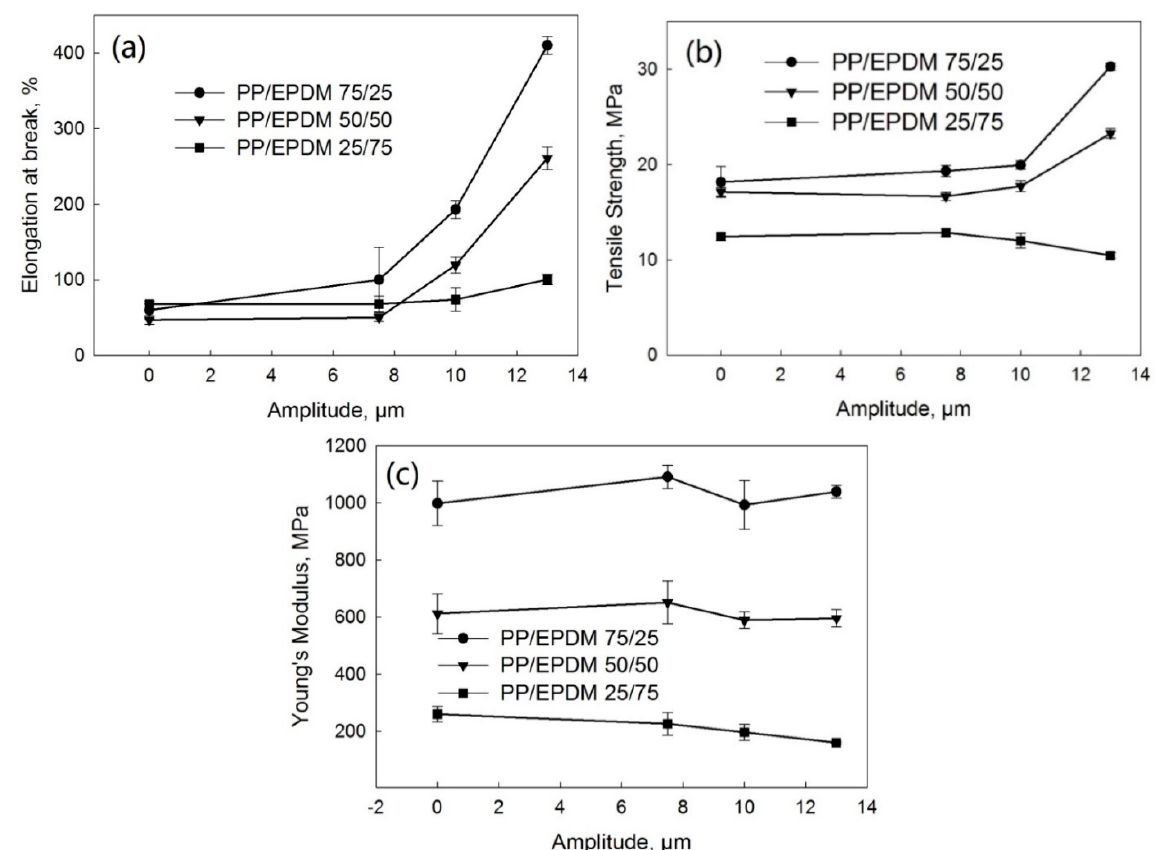
Figure 15. Elongation at break ( a ), tensile strength ( b ), and Young’s modulus ( c ) as a function of ultrasonic amplitude for PP/EPDM blends of various ratios prepared by the DR method.